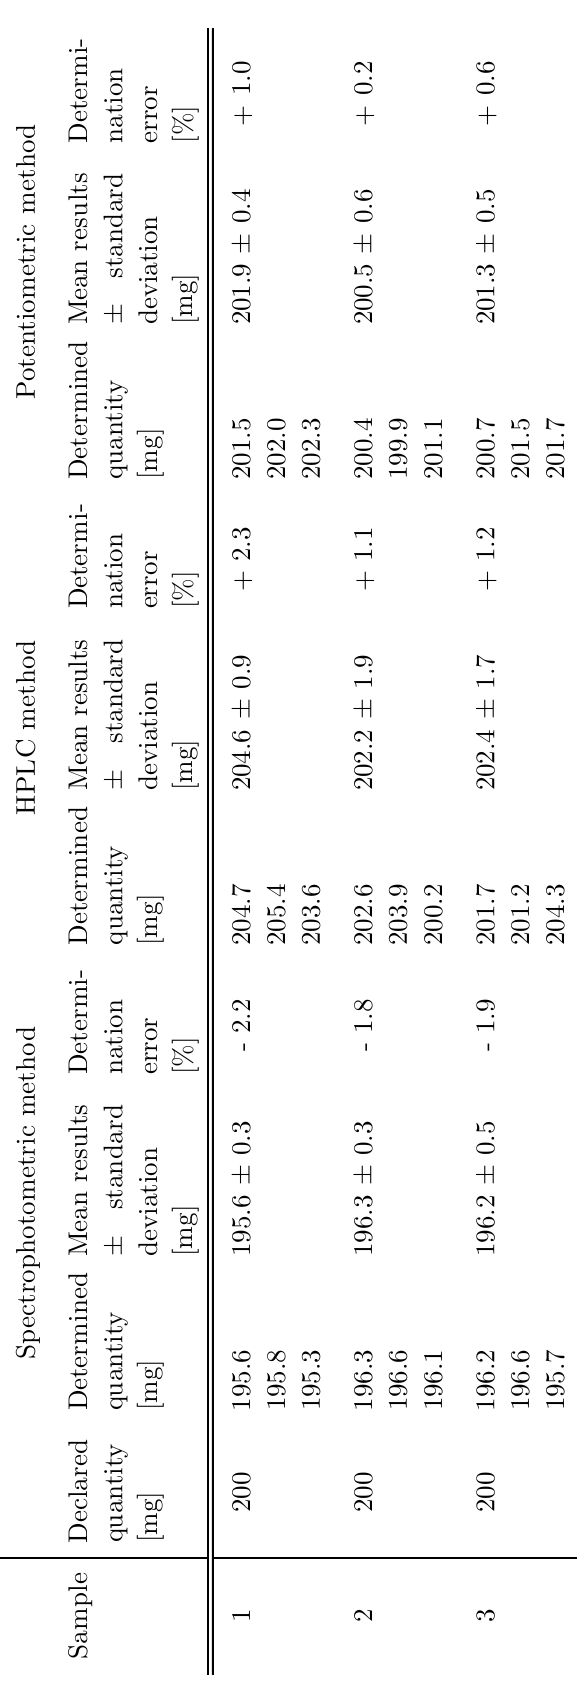
Table 4 Results of labetalol hydrochloride determination in (Pressocard